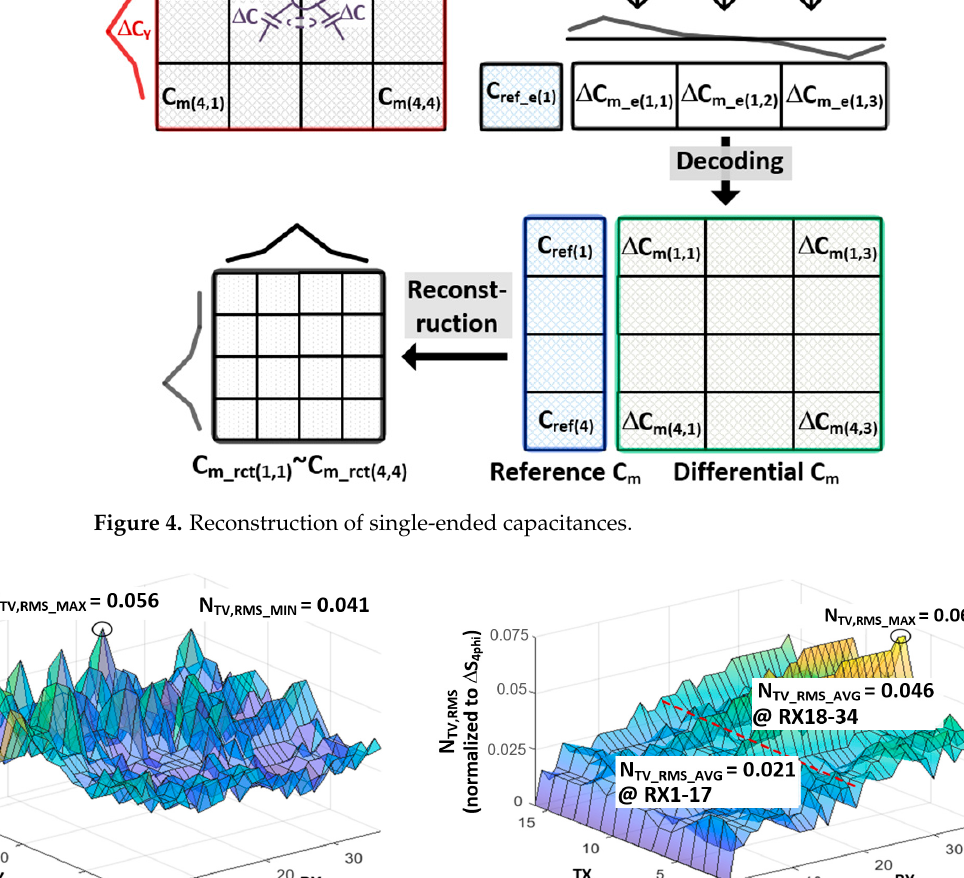
Figure 5. RMS noise values measured in ( a ) single-ended and ( b ) differential-sensing manners.